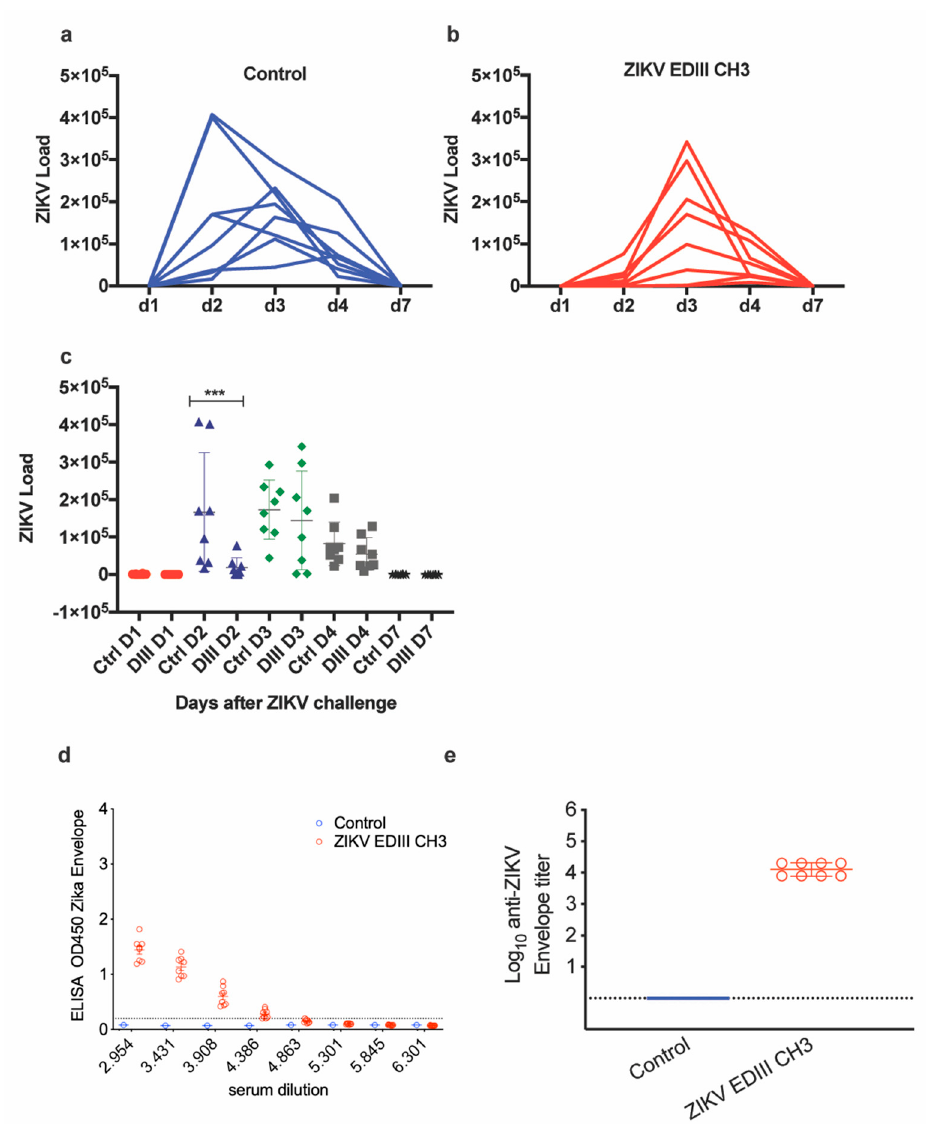
Figure 3. Assessment of protective efficacy induced by protein-based EDIII vaccine. Naïve ( a ) and vaccinated ( b ) mice ( n = 8) were intravenously challenged at four weeks after vaccination with 10 4 PFU of ZIKV- PRVABC59 strain. Upon ZIKV challenge, the viral load was monitored for up to seven days. Graphs show days post-challenge on the x -axis versus viral load on the y -axis. Continuous blue and red lines represent one mouse each for each of the control and vaccinated groups. ( c ) Peaks of viral titers for each individual mouse and for each group. ( d ) Sera from immunized mice were tested for ELISA reactivity on ZDIII-coated plates; the dashed line marks the limit of the assay. ( e ) Antibody titers from the curves shown in (b). *** p < 0.001